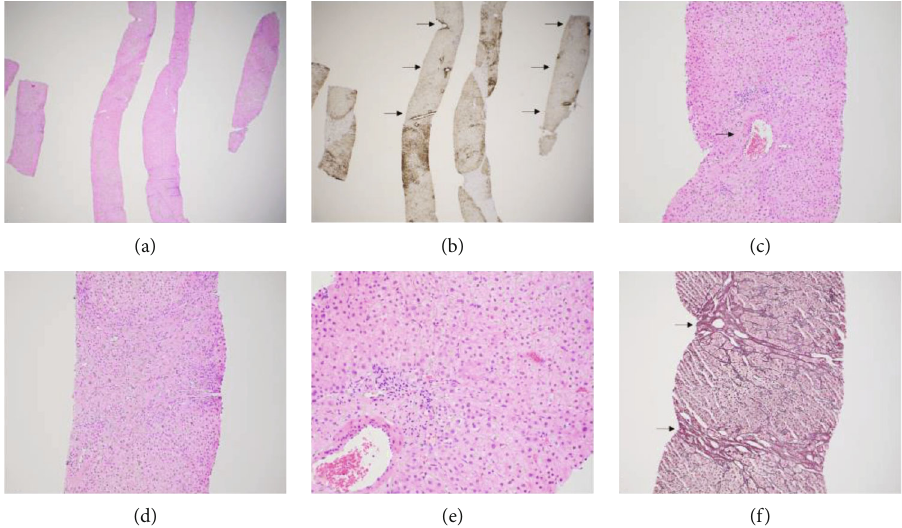
Figure 4: (a) The boundary between normal liver tissue and the lesional tissue is di ffi cult to appreciate on H&E stain on low power (H&E stain, 20x magni fi cation). (b) However, immunohistochemical stain for glutamine synthetase highlights the lesional area with patchy brown staining. Nodular architectural typical for FNH is also more evident. Adjacent normal liver tissue (arrows) shows the characteristic perivenular staining only (glutamine synthetase immunohistochemical stain, 20x magni fi cation). (c) Large abnormal muscular arteries (arrow) without associated bile ducts of similar size are seen, a characteristic feature of FNH (H&E stain, 100x magni fi cation). (d) Large fi brous tracts with ductular proliferation, similar to that seen in cirrhotic livers, is seen within the lesion (H&E stain, 100x magni fi cation). (e) On high power, the hepatocytes within the lesion appear similar in appearance to the background nonlesional hepatocytes. No signi fi cant cell plate architectural abnormality or cytologic atypia diagnostic of hepatocellular carcinoma is identi fi ed (H&E stain, 200x magni fi cation). (f) Reticulin stain highlights fi brous tracts within the lesion (arrows). Also, signi fi cant thickening of the hepatocellular plates, a feature of hepatocellular carcinoma, is absent (reticulin stain, 100x magni fi